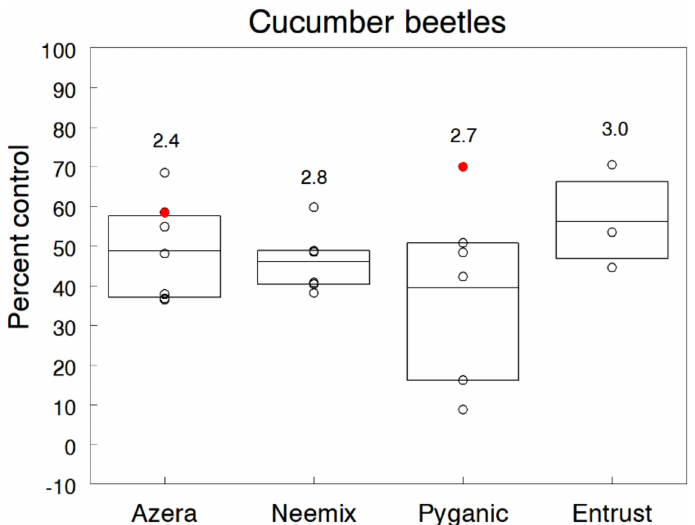
Figure 5. Percent control of cucumber beetles with weekly applications of Azera, Neemix, PyGanic and Entrust relative to the untreated control. Mean data are given in four cucumber trials and two zucchini trials. Box-whisker plots show the 25% and 75% percentile range of percent control data and the horizontal line in each box is the overall mean control e ffi cacy. Number above each plot indicates the average number of weekly applications. Application rates of Azera, Neemix, PyGanic and Entrust were 2.34 L / h, 1169 mL / h, 2.34 L / h and 71.2 g a.i. / h respectively, except for trial data in red indicating